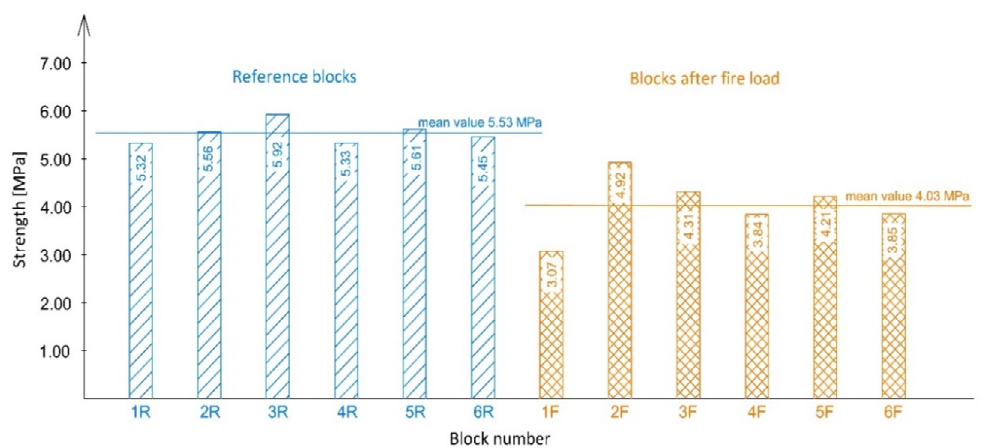
Figure 12. Results of compressive strength tests.